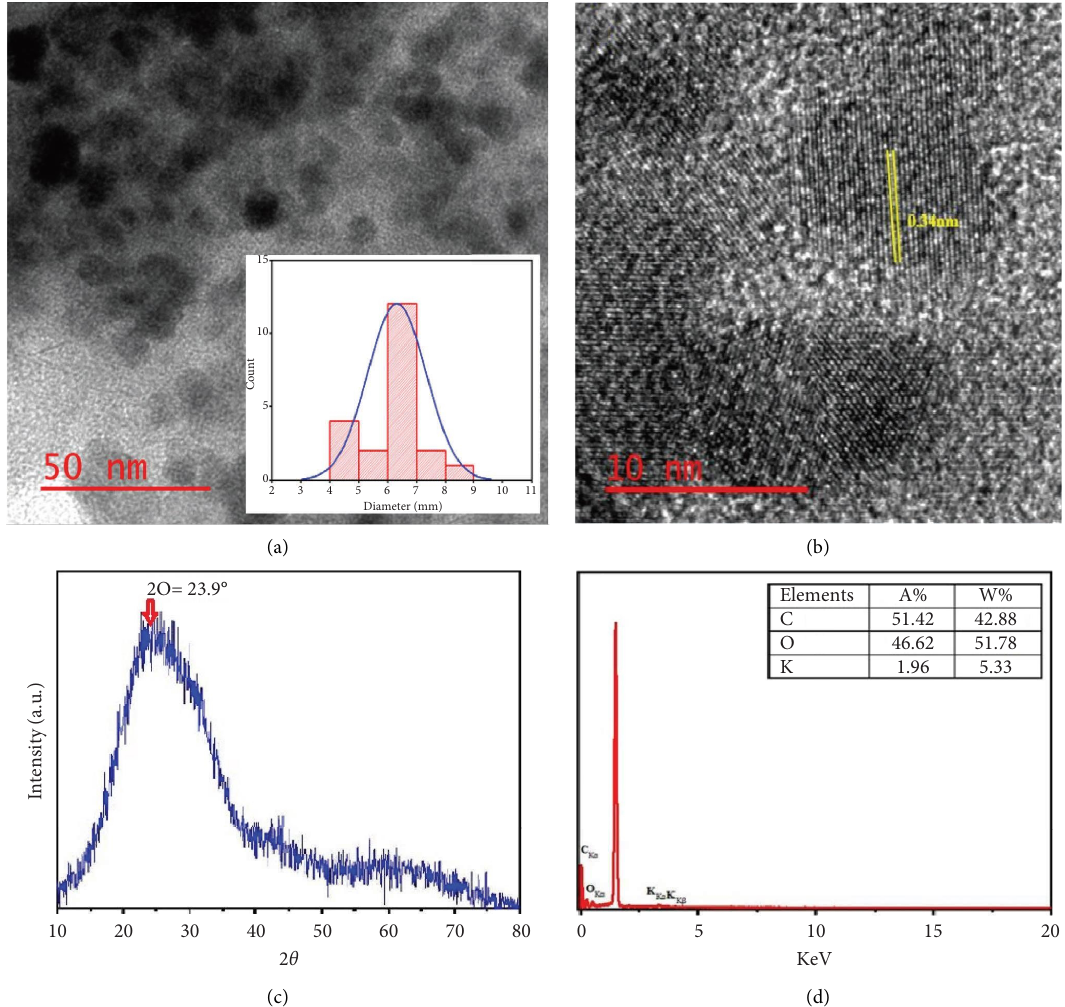
Figure 2: (a) TEM image and size distribution inset, (b) HR-TEM image and lattice spacing, (c) X-ray difraction spectrum of the HP-CQDs, and (d) EDX